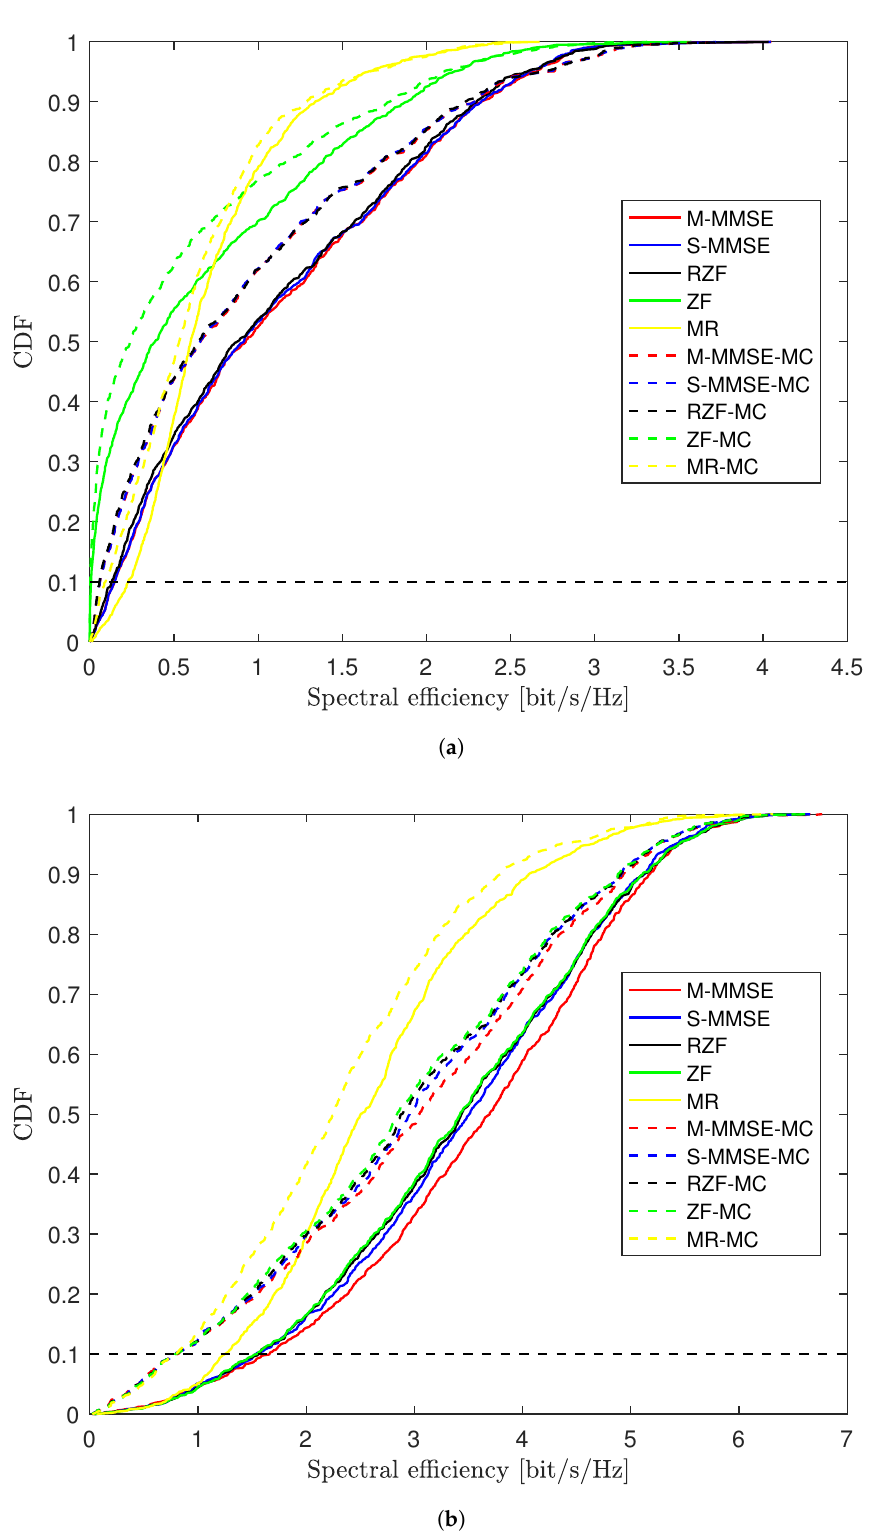
Figure 4. CDF of the spectral efficiency with and without mutual coupling when inter-element spacing d = 0.1 λ and the number of antenna elements ( a ) N = 20, ( b ) N =